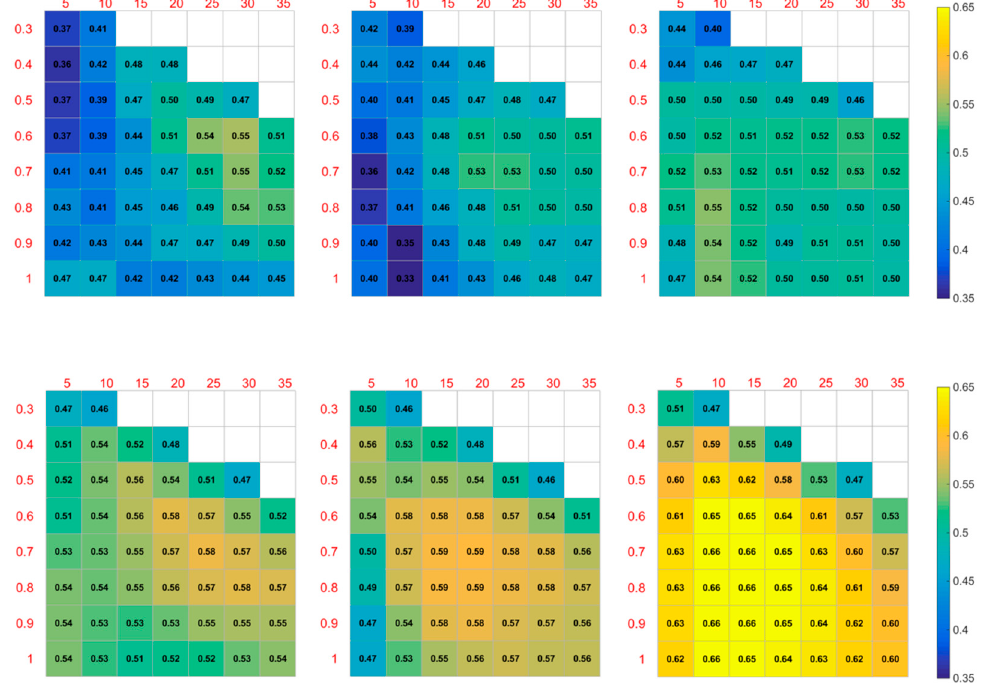
Figure 9. The test scores ( upper panel ) and repeated 10-fold CV scores ( lower panel ) for different C thrd s and N pre s, and predictor-selection schemes single-MLR ( left panel ), F-ratio ( middle panel ), and L1 ( right panel ).